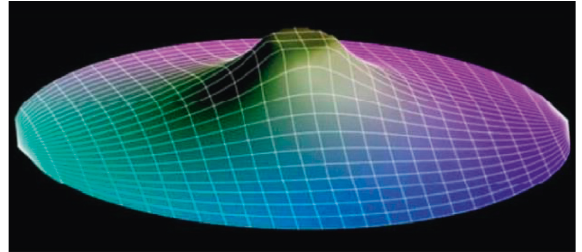
Figure 3: Force and deformation diagram of tennis racket surface. Table 1: The speed and control score of different material